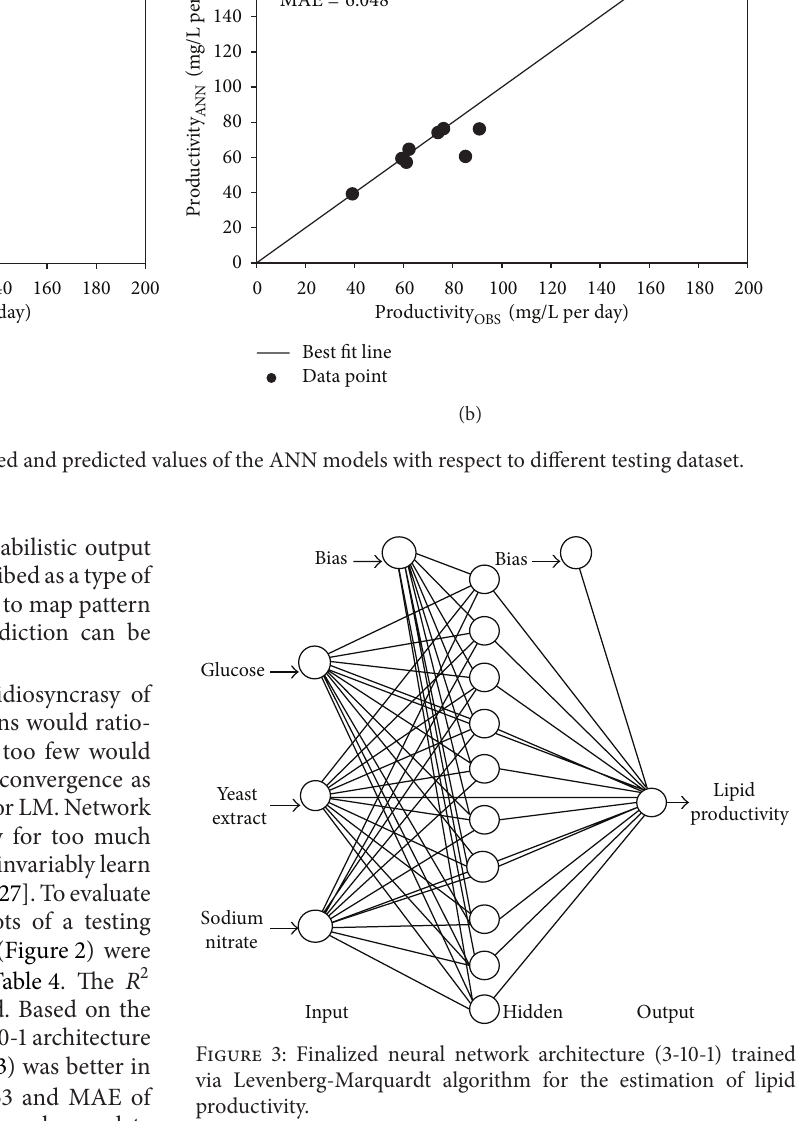
Figure 3: Finalized neural network architecture (3-10-1) trained via Levenberg-Marquardt algorithm for the estimation of lipid